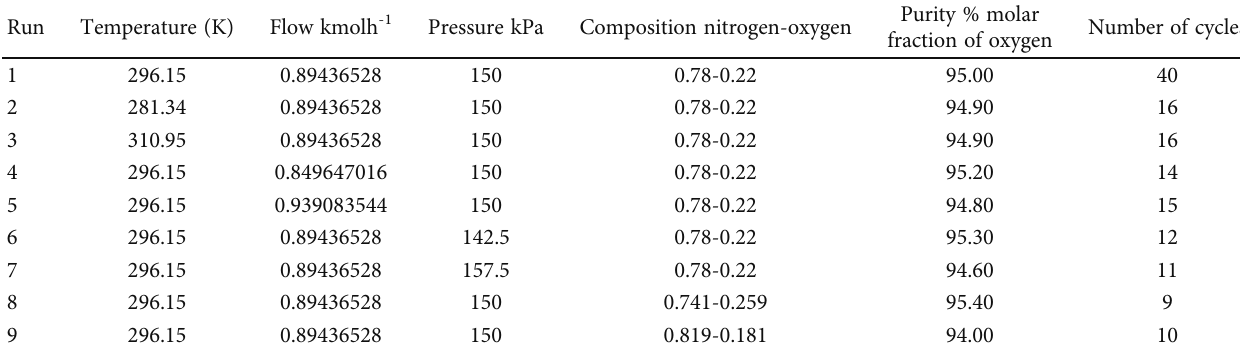
Figure 11: Sensitivity analysis applied to the PSA process for the production of medical oxygen. Table 19: Analysis of the possible input variables that have the greatest e ff ect on the purity obtained.